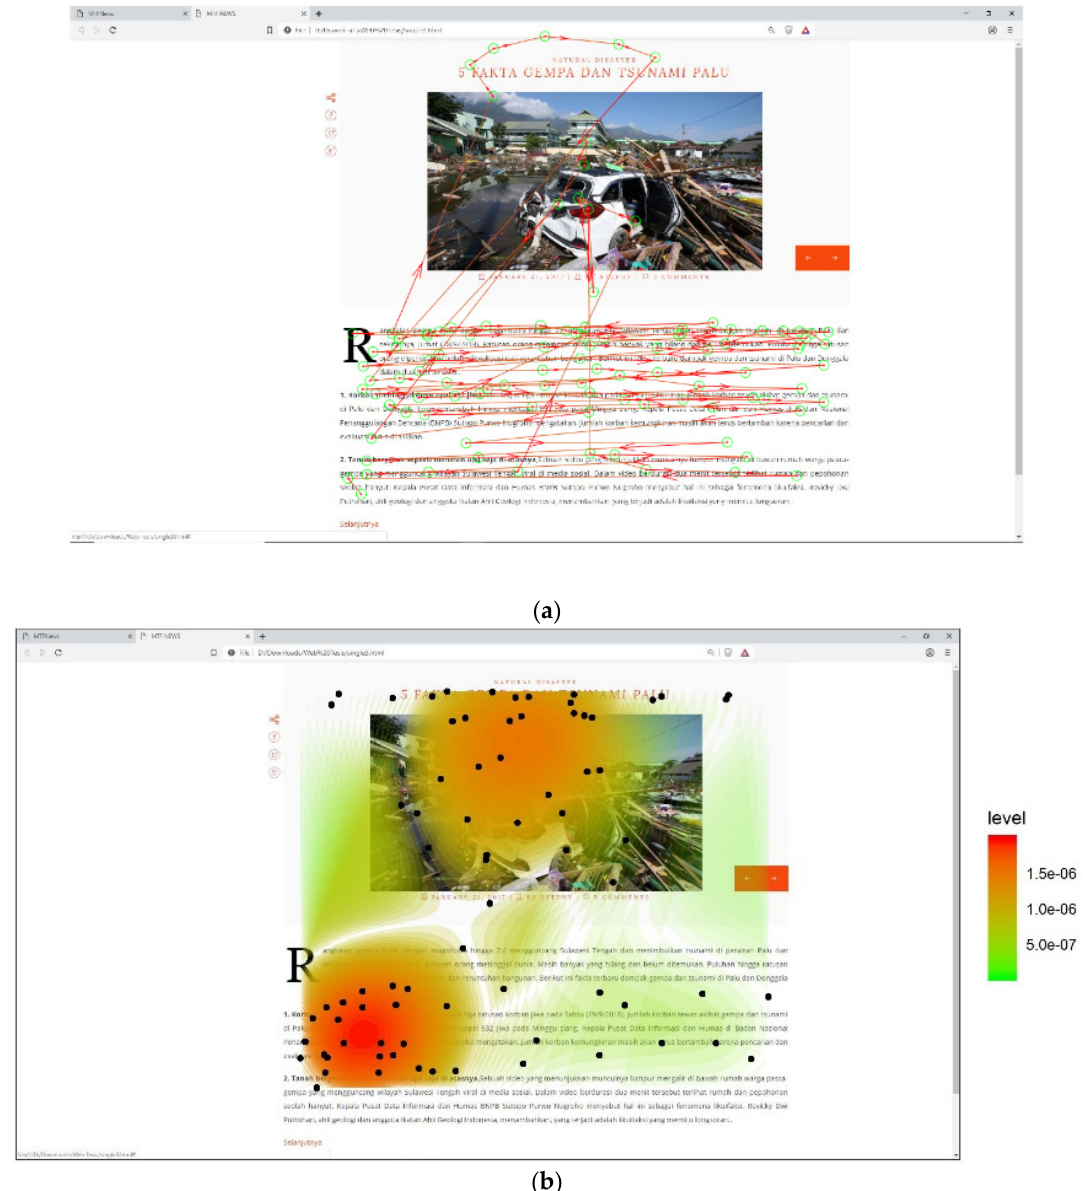
Figure 2. (a). Example of gaze plot; (b) example of heat map. Figure 2. ( a ) Example of gaze plot; ( b ) example of heat